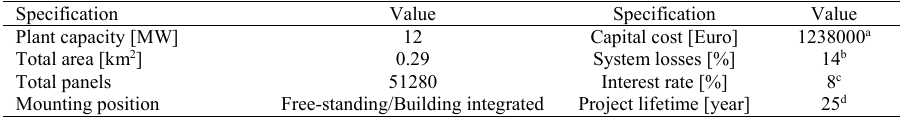
Table 9: General specification of the all PV power plants and assumptions for the economics of solar energy Specification